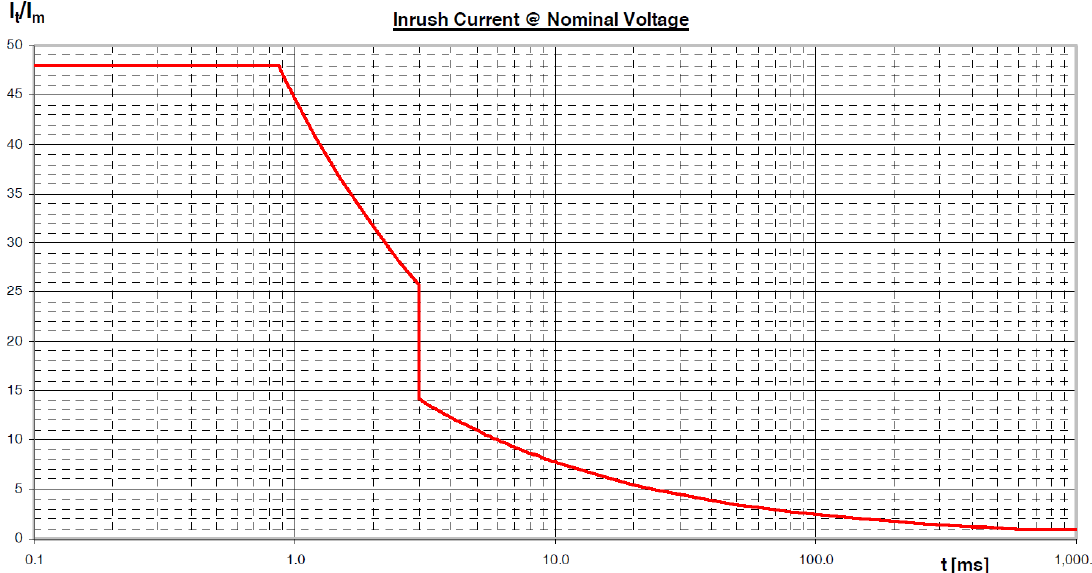
Figure 4. Inrush limits for telecommunications and data centers (EN 300 132-2 [111] © ETSI 2019. All rights reserved), having indicated with I m the maximum steady state input current of the ICT equipment.